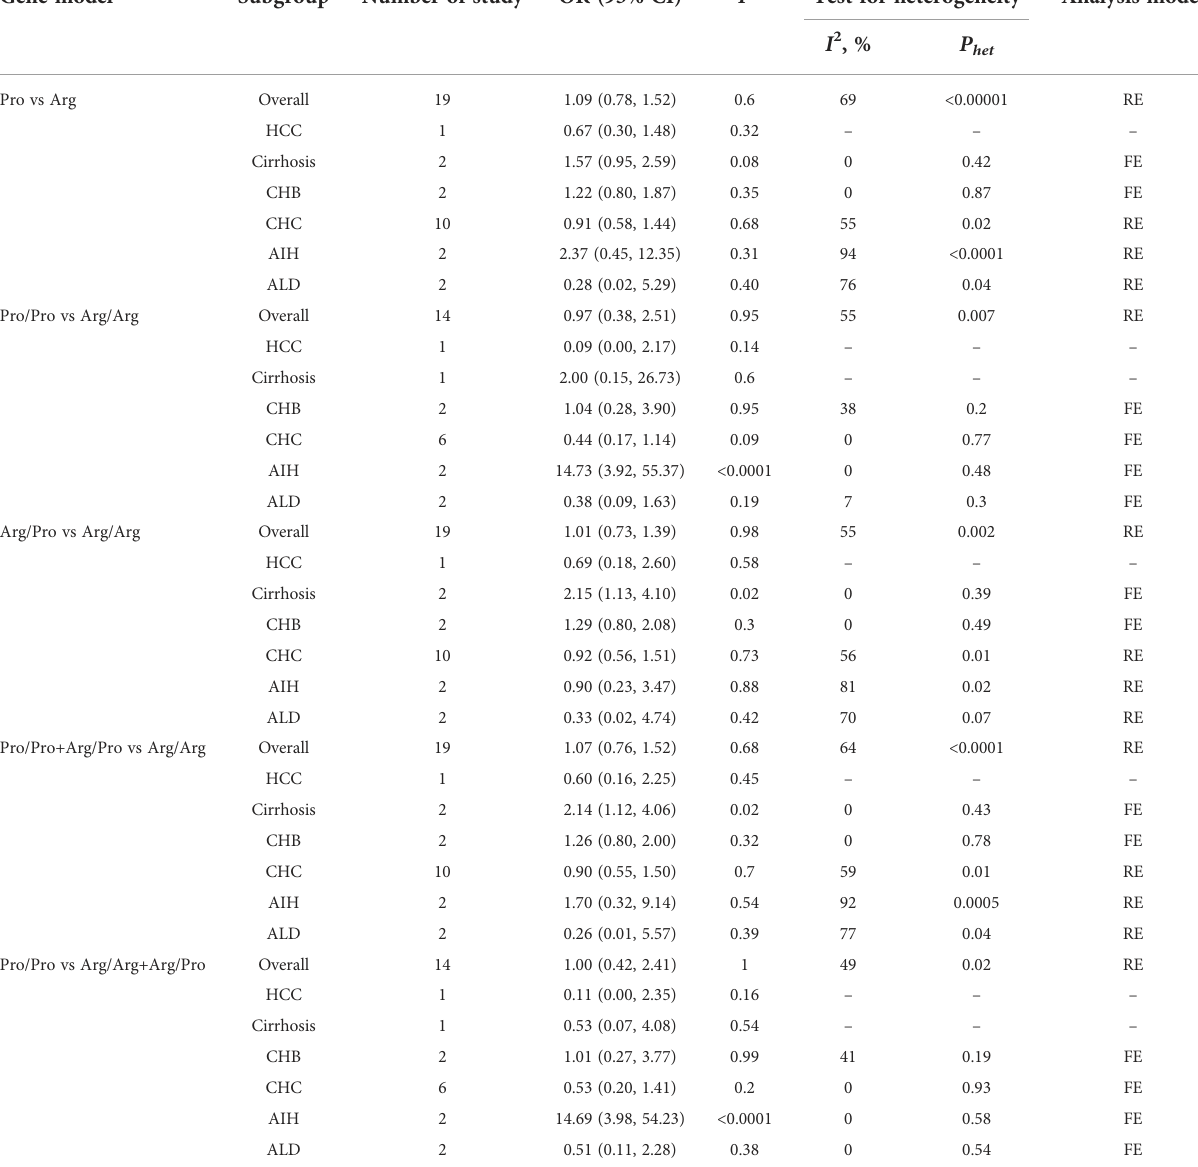
TABLE 8 Subgroups results of the role of TGF- b 1 codon 25 polymorphism in different